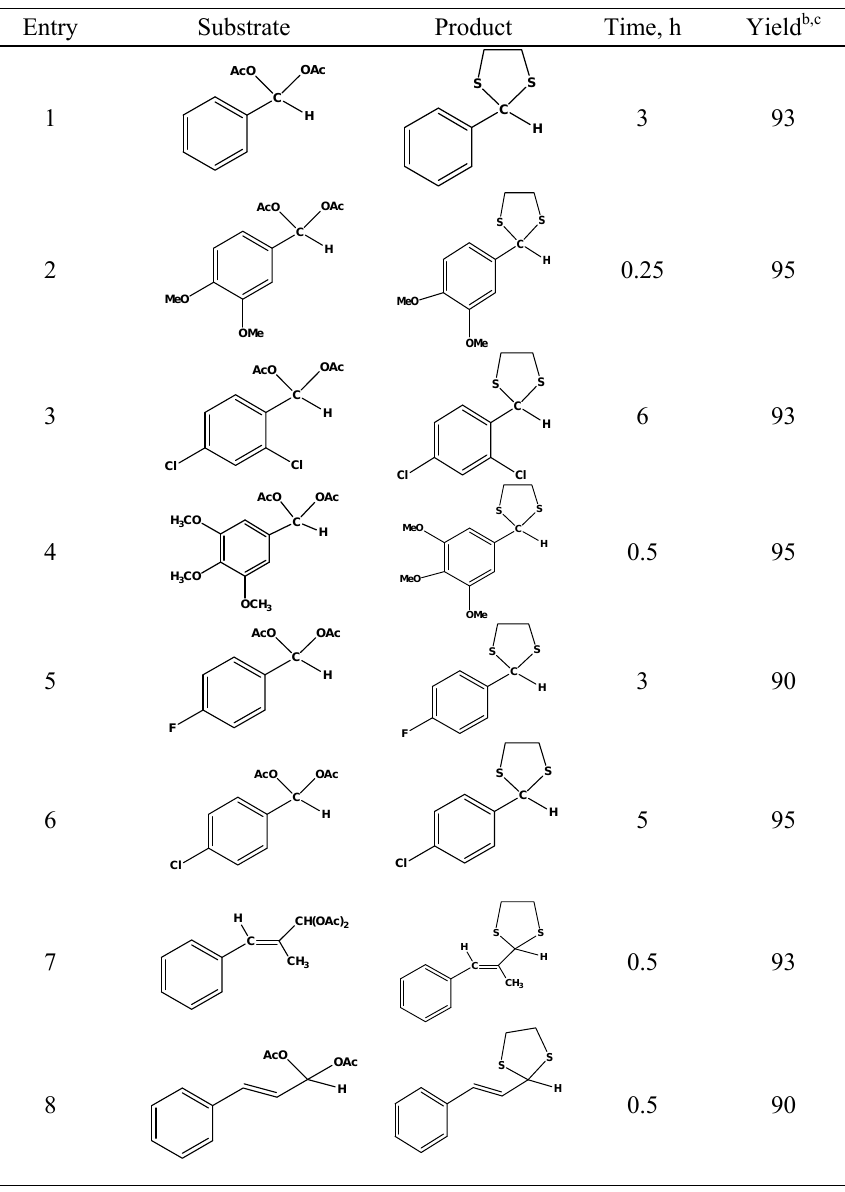
Table 2. Transthioacetalization of acylals using BABOT and 1,2-ethandithiol at rt a